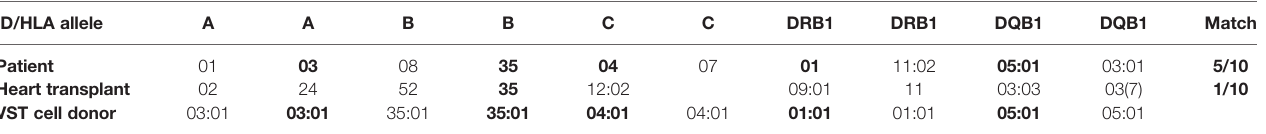
ACT, adoptive cell transfer; VST, virus-speci fi c T cells; HLA, human leukocyte antigen; bold values indicate HLA allele